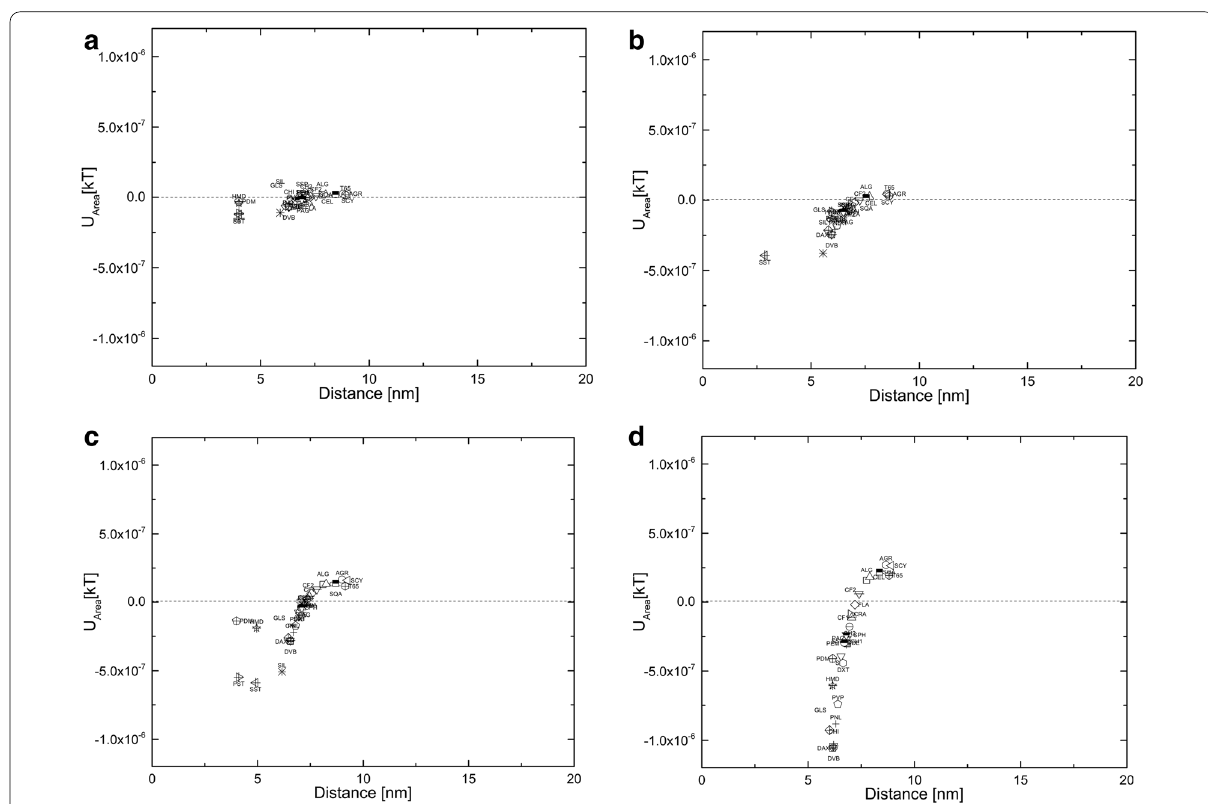
Fig. 3 The interaction energy Vs distance profiles of biomass as function of distance for a E. Coli , b B. subtilis, c S. cerevisiae and d CHO cells